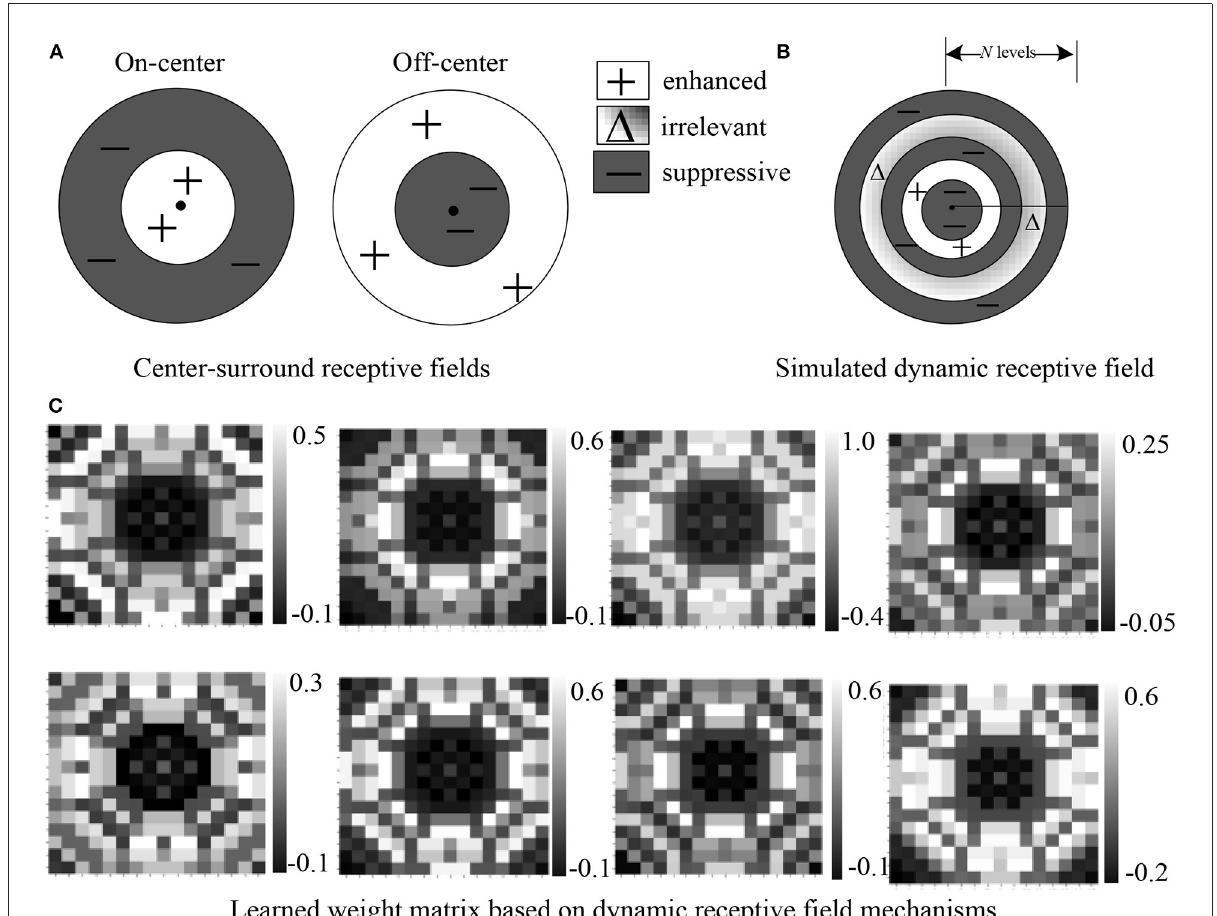
FIGURE1 Our proposed dynamic receptive field module (B) imitates the biological mechanisms of center-surround receptive fields of both On-center and Off-center neurons (A) . A simulated dynamic receptive field can be divided into various regions of N discrete levels where each region is assigned a weight indicating enhancement, suppression, or no change. (C) Visualization of eight weight maps with positive and negative values learned from the dataset. We can see that the automatically learned weight matrix based on DRF is quite similar to (B)